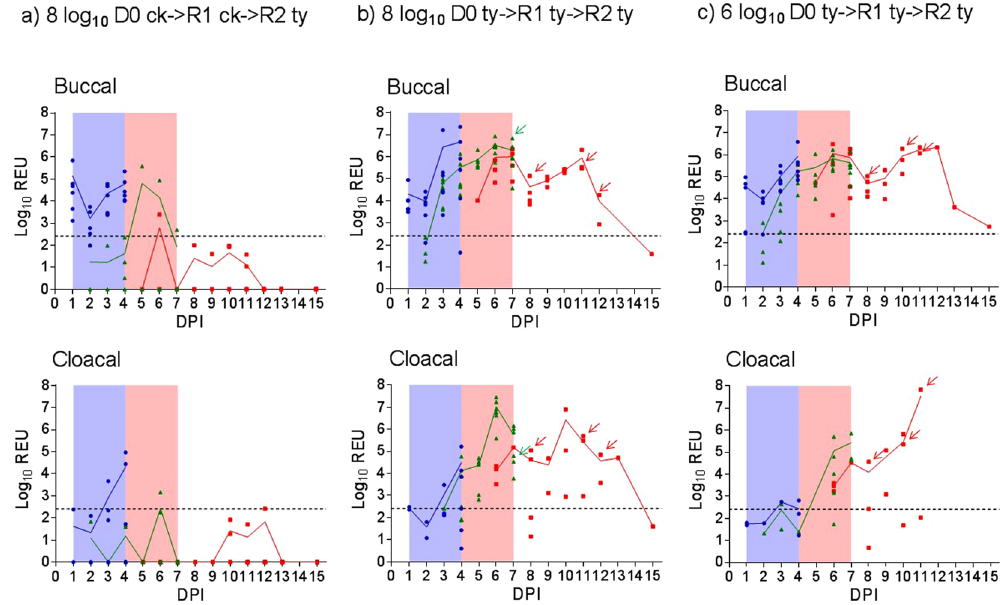
Figure 2. Buccal and cloacal H7N9 viral shedding (mean (line) and individual bird (symbols)) during direct- and contact-infection. ( a , b and c ) denote the three pens where doses of 8, 8 and 6 log 10 EID 50 per bird were directly administered to the D0 group (n = 6) in each pen, namely chickens (ck), turkeys (ty) and turkeys respectively. R1 (n = 6) and R2 (n = 4) contact groups were introduced to each pen at 1 and 4 dpi respectively, in order to attempt the transmission: ( a ) D0 ck- > R1 ck- > R2 ty; ( b ) D0 ty- > R1 ty- > R2 ty and ( c ) D0 ty- > R1 ty- > R2 ty. Blue circles, green triangles and red squares indicate D0, R1 and R2 individual birds’ shedding titres respectively. See Fig. 1 and Methods section for planned withdrawl times of D0, R1 and R2 groups, with blue and pink shading indicating the D0/R1 and R1/R2 cohousing periods respectively. Arrows indicate final sampling of R1 and R2 turkeys in (b) and (c) which were either found dead or required euthanasia (Fig. 3). Broken horizontal line indicates the threshold for viral RNA REU shedding values.